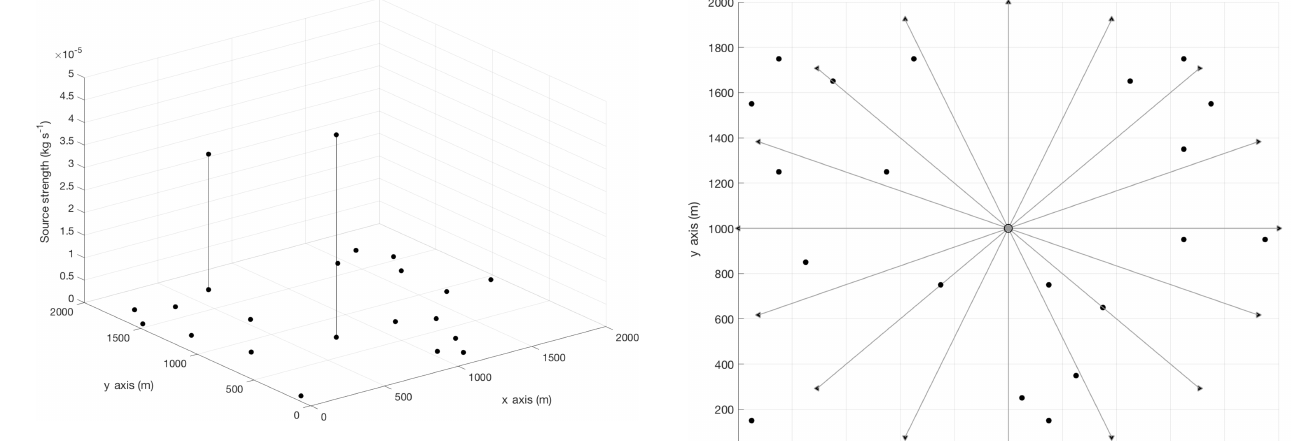
Figure 1. Synthetic test observation area: 2km × 2km domain with 20 source locations (black dots) at randomly distributed x and y locations (position shown on x and y axes). Of 20 point sources, well site 6 ( x = 750, y = 750) and well site 19 ( x = 650, y = 1750) have non-zero source strengths (shown on the z axis).